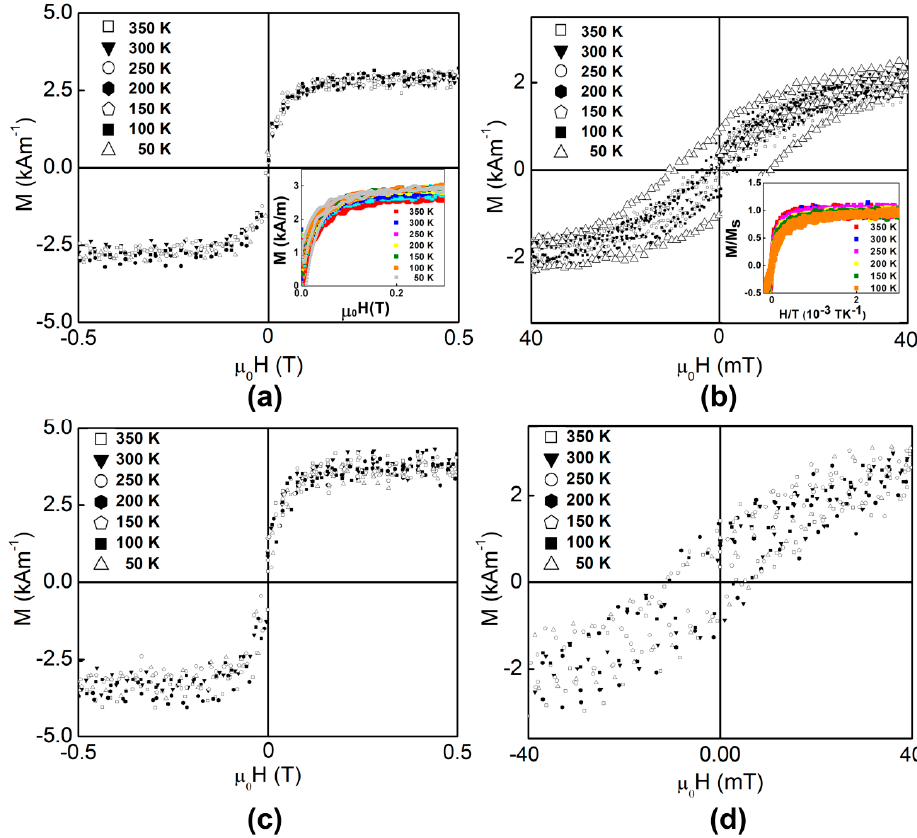
Figure 8. Magnetic hysteresis loops and zoomed views of the magnetic coercivities: ( a , b ) LTO:Fe-HC; ( c , d ) LTO:Fe-LC.